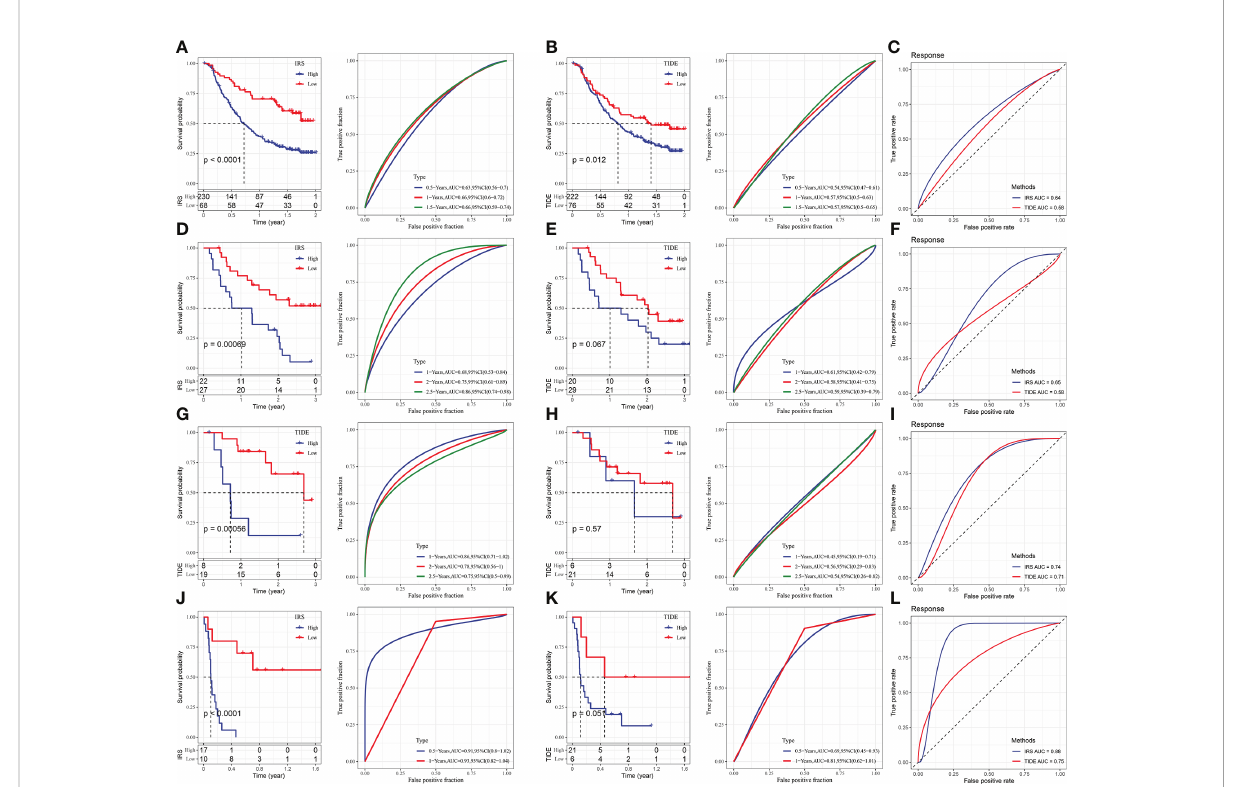
FIGURE 10 Comparison and analysis of IRS and TIDE. (A) IRS survival curve and ROC curve of IMvigor210 dataset. (B) TIDE survival curve and ROC curve of IMvigor210 dataset. (C) ROC curve of IRS and TIDE on immunotherapy effect in imvigor210 dataset. (D) IRS survival curve and ROC curve of GSE91061 dataset. (E) TIDE survival curve and ROC curve of GSE91061 dataset. (F) ROC curve of IRS and TIDE on immunotherapy effect in GSE91061 dataset. (G) IRS survival curve and ROC curve of GSE78220 dataset. (H) TIDE survival curve and ROC curve of GSE78220 dataset. (I) ROC curve of IRS and TIDE on immunotherapy effect in GSE78220 dataset. (J) IRS survival curve and ROC curve of GSE135222 dataset. (K) TIDE survival curve and ROC curve of GSE135222 dataset. (L) ROC curve of IRS and TIDE for immunotherapy effect in GSE135222